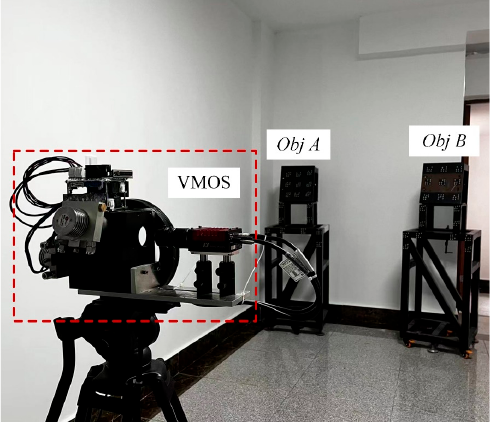
Figure 18. Scene of the pose estimation experiment using the VMOS.